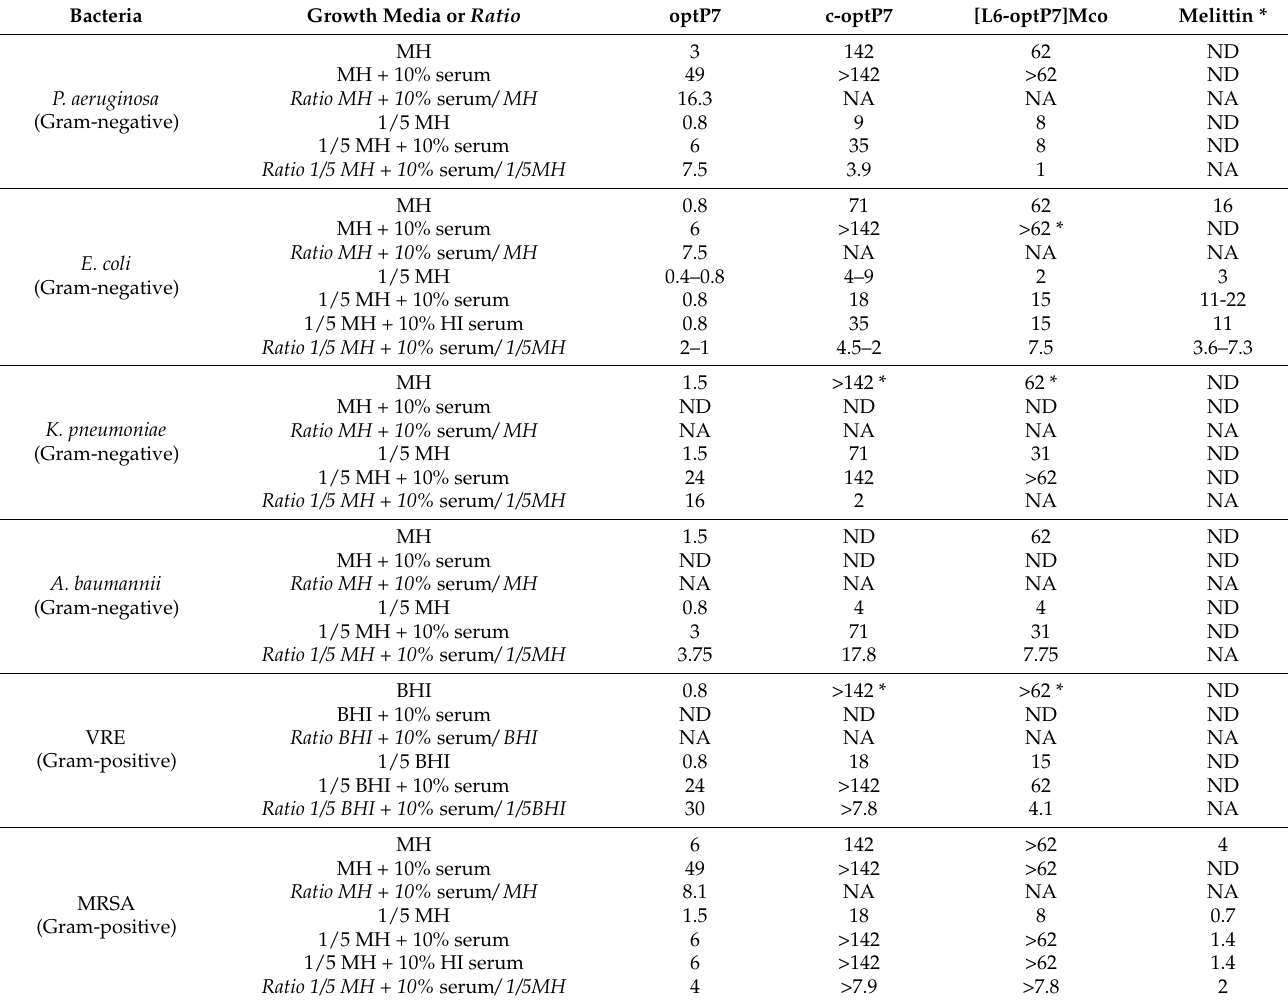
Table 2. Minimum inhibitory concentration (MIC) in µ